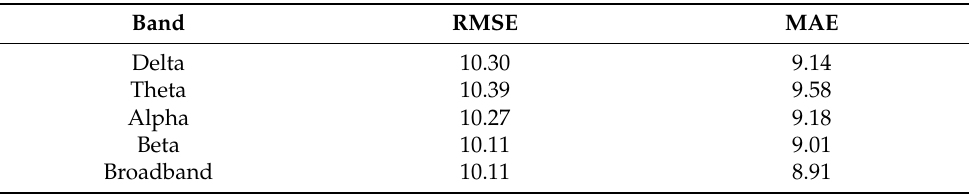
Table 5. BDI regression performance of signal-based baseline model.